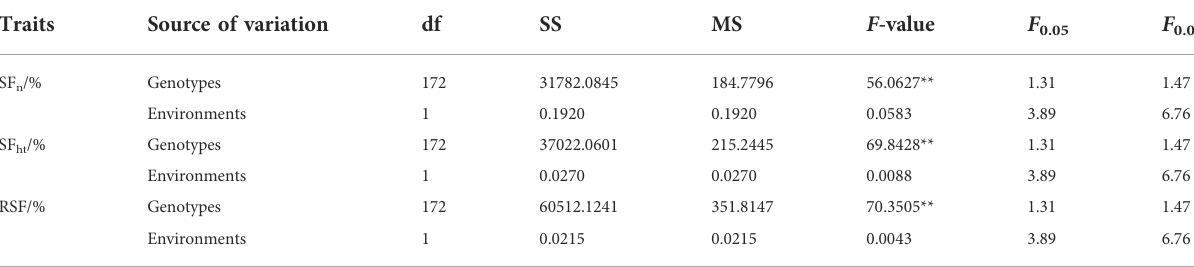
TABLE 1 The results of analysis of variance for the heat tolerance-related traits.